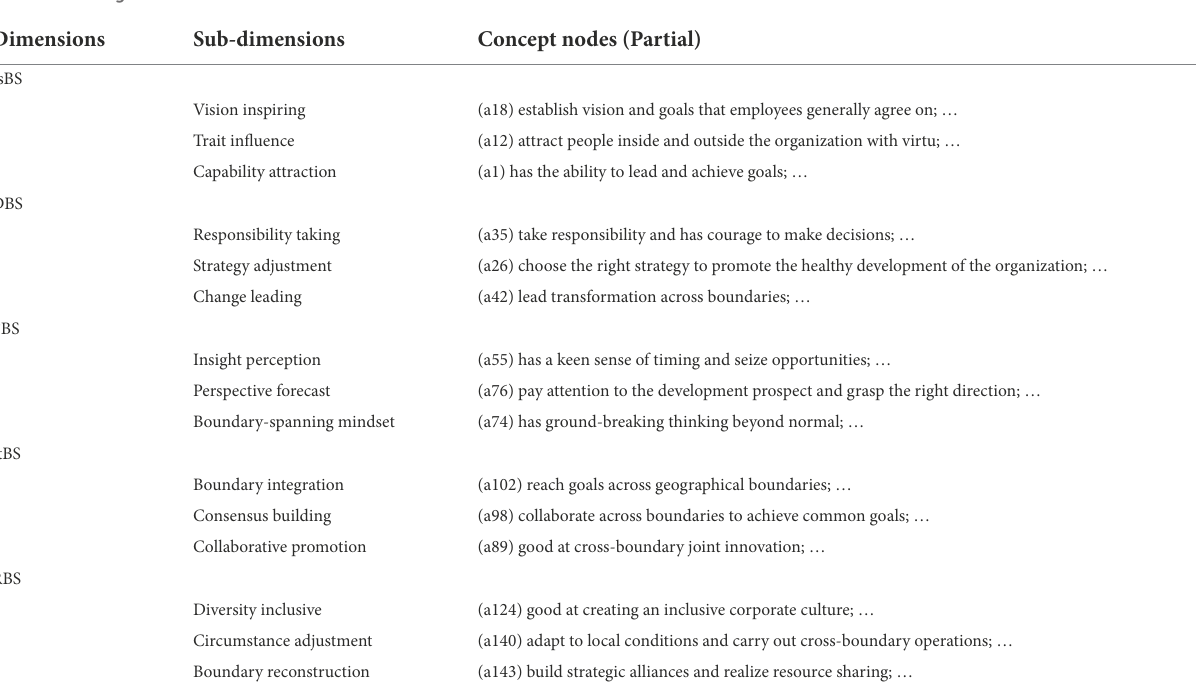
TABLE 1 Coding results of